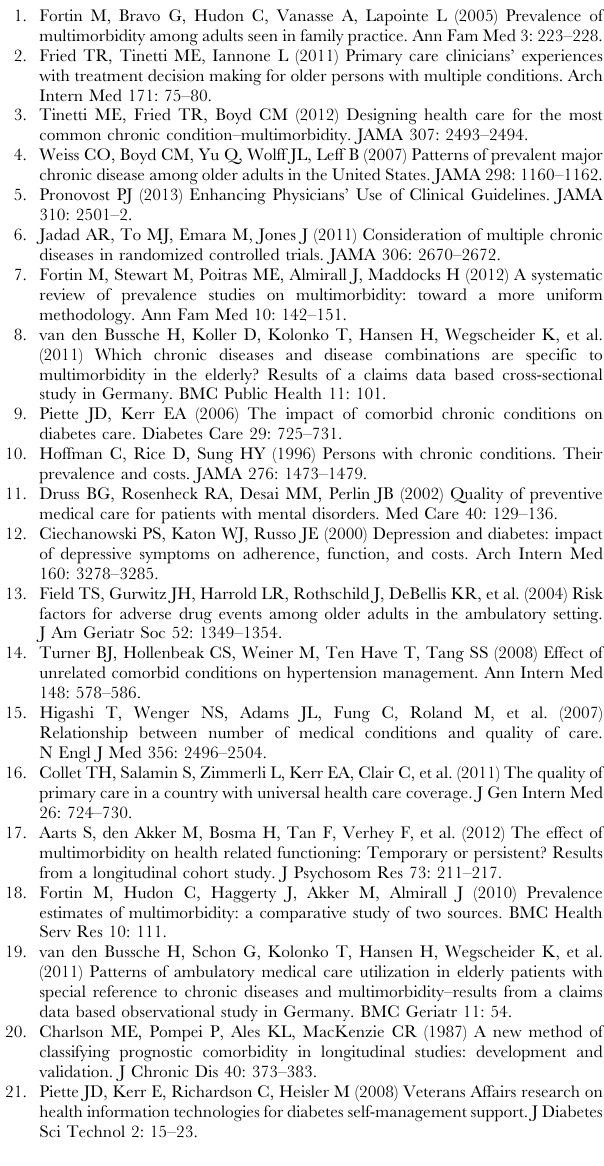
Table S1 Selected quality indicators for preventive and cardiovascular preventive care. Table S2 Weighted index of the Charlson index.